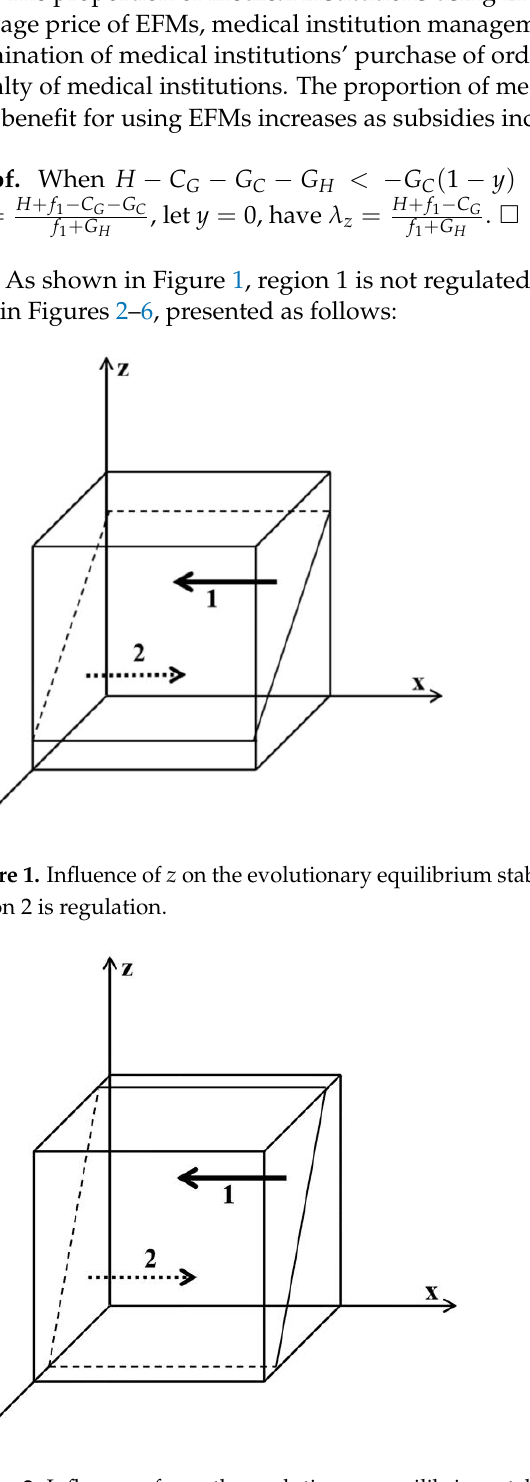
x . Region 1 is no